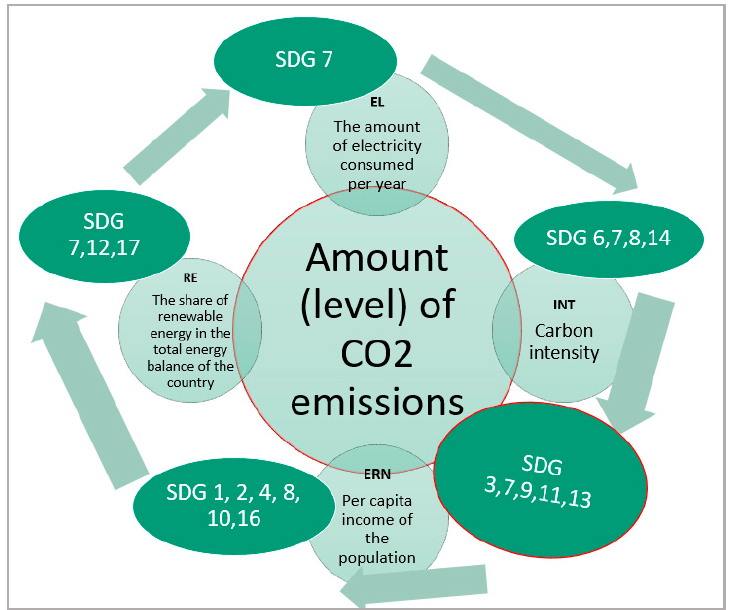
Figure 5. Relationship between the outcome model indicators and the Sustainable Development